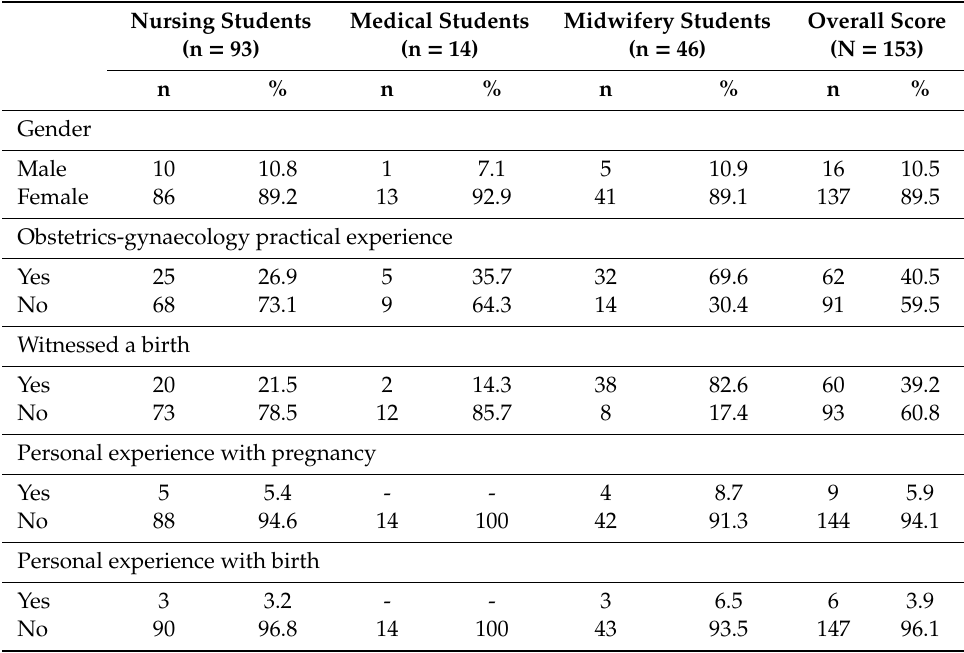
Table 1. Sociodemographic characteristics (N =